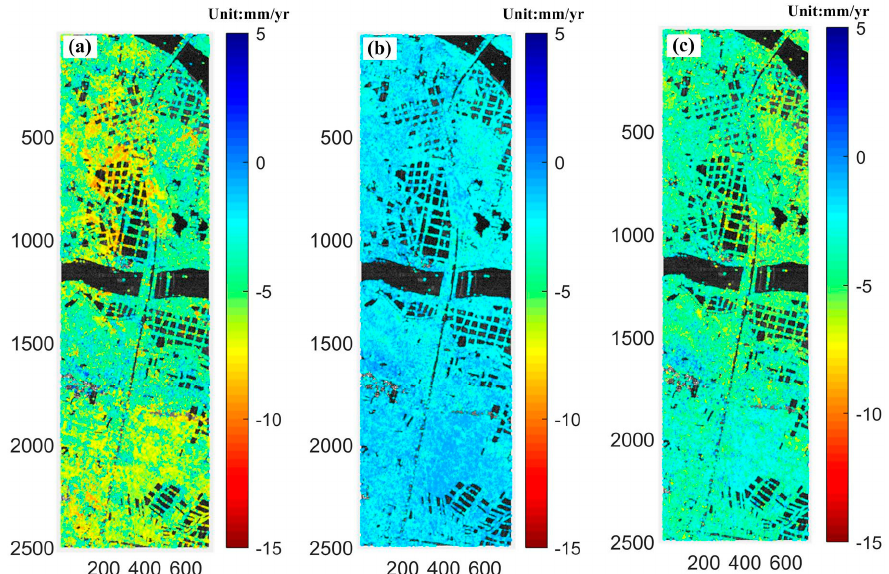
Figure 8. LOS deformation parameters of SM: ( a ) Parameter s 1 ; ( b ) Parameter s 2 ; ( c ) Parameter s 3 .